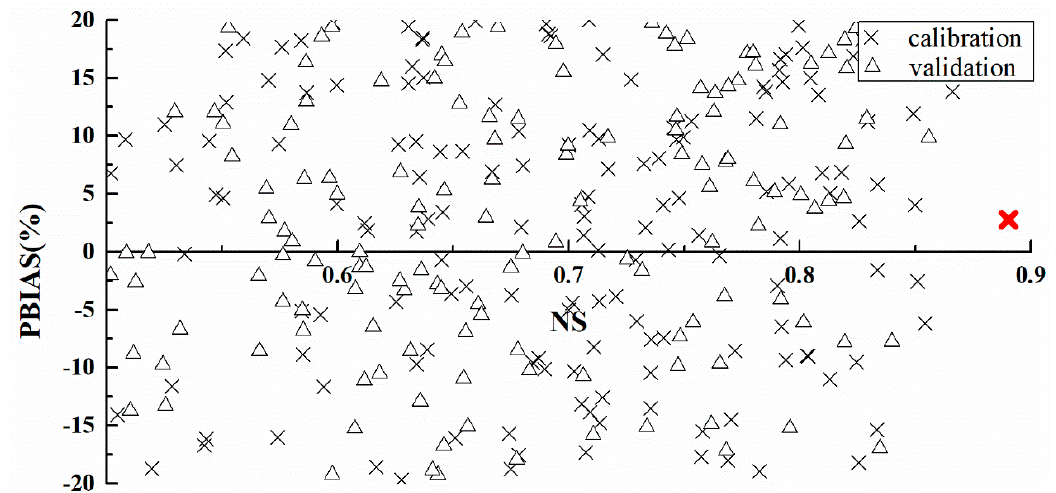
Figure 3. Distributions of NS and PBIAS achieved via a batch-processing module driven by Tropical Rainfall Measuring Mission (TRMM) 3B42V7.